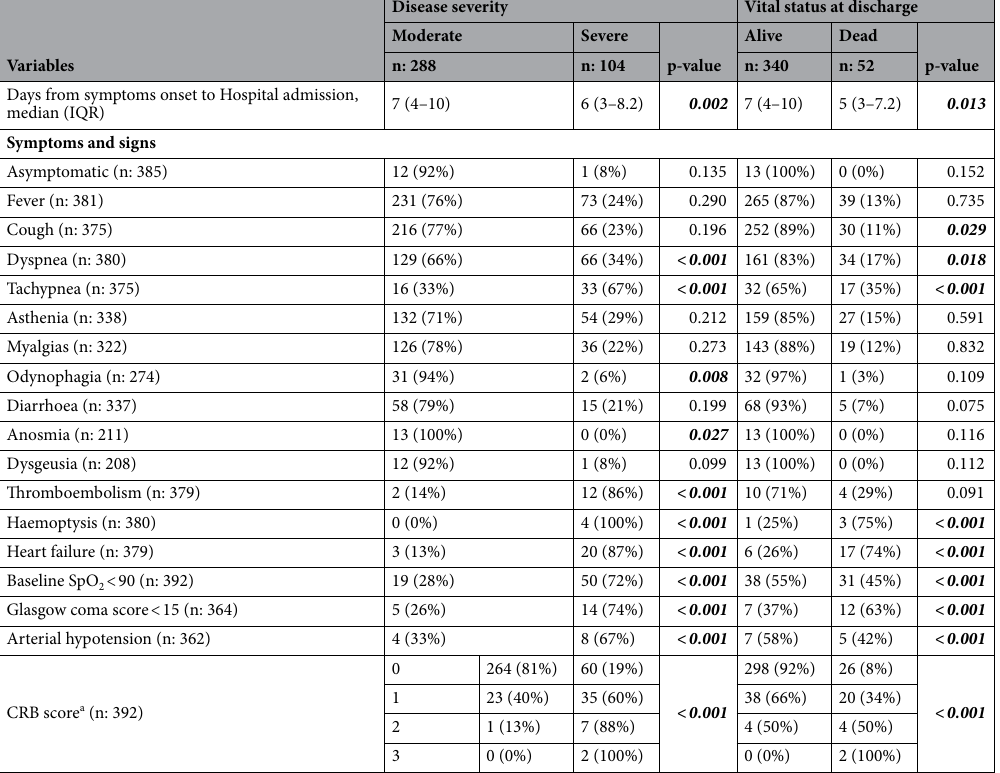
Table 2. Symptoms and signs at presentation. According to the development of severe disease and vital status at discharge. IQR: interquartile range. SpO 2 : arterial saturation by pulse oximetry. In each outcome, absolute frequency, percentage by outcome and p-values for the comparation of moderate vs severe disease and alive vs dead at discharge are shown. a In the CRB score the vast majority of the patients had a score of zero (83%), which makes the quartiles and range very uninformative, so for a better description in the bivariate analysis we show the absolute and relative frequencies of all values (0–3); its p-value compares 0 points versus more than 0. In each variable, total number of valid data is specified in the first column. In bold and italic those associations that are statistically